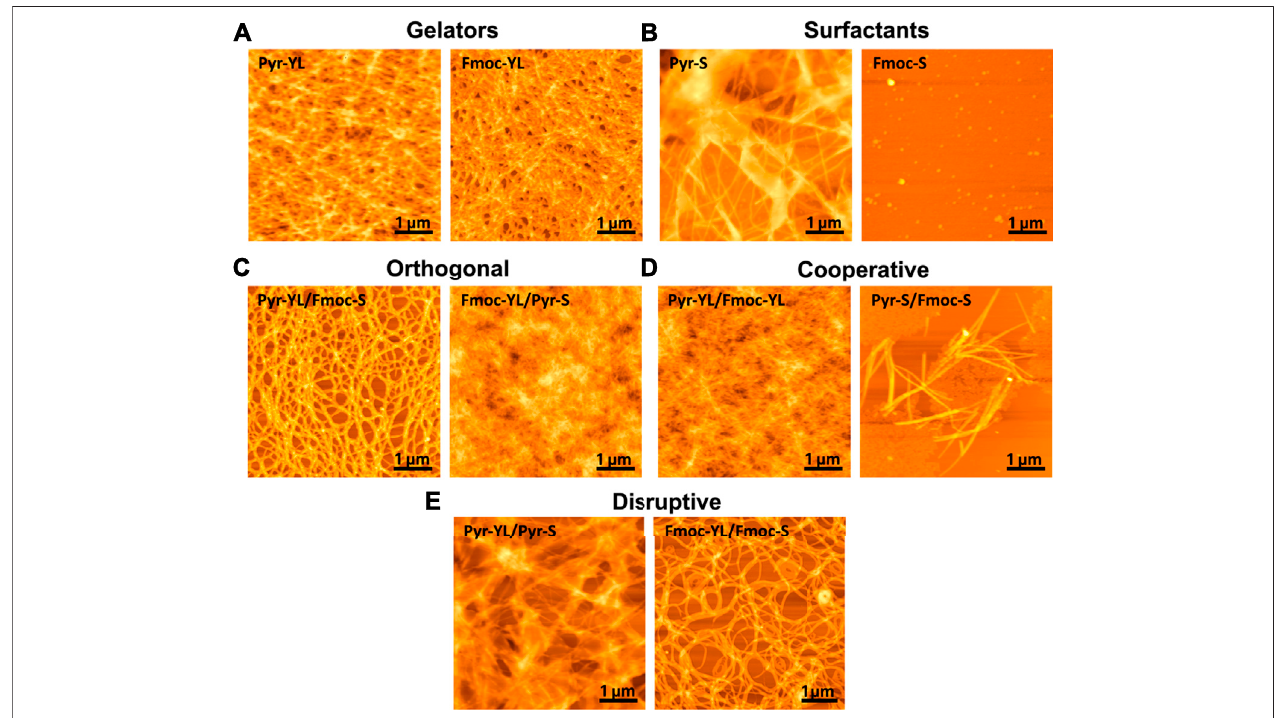
FIGURE 14 | AFM of (A) the gelators Pyr-YL and Fmoc-YL; (B) the surfactants Fmoc-S and Pyr-S; (C) orthogonal Pyr-YL/Fmoc-S and Fmoc-YL/Pyr-S; (D) cooperative Pyr-YL/Fmoc-YL and Pyr-S/Fmoc-S; (E) disruptive Pyr-YL/Pyr-S and Fmoc-YL/Fmoc-S (Fleming et al., 2014).